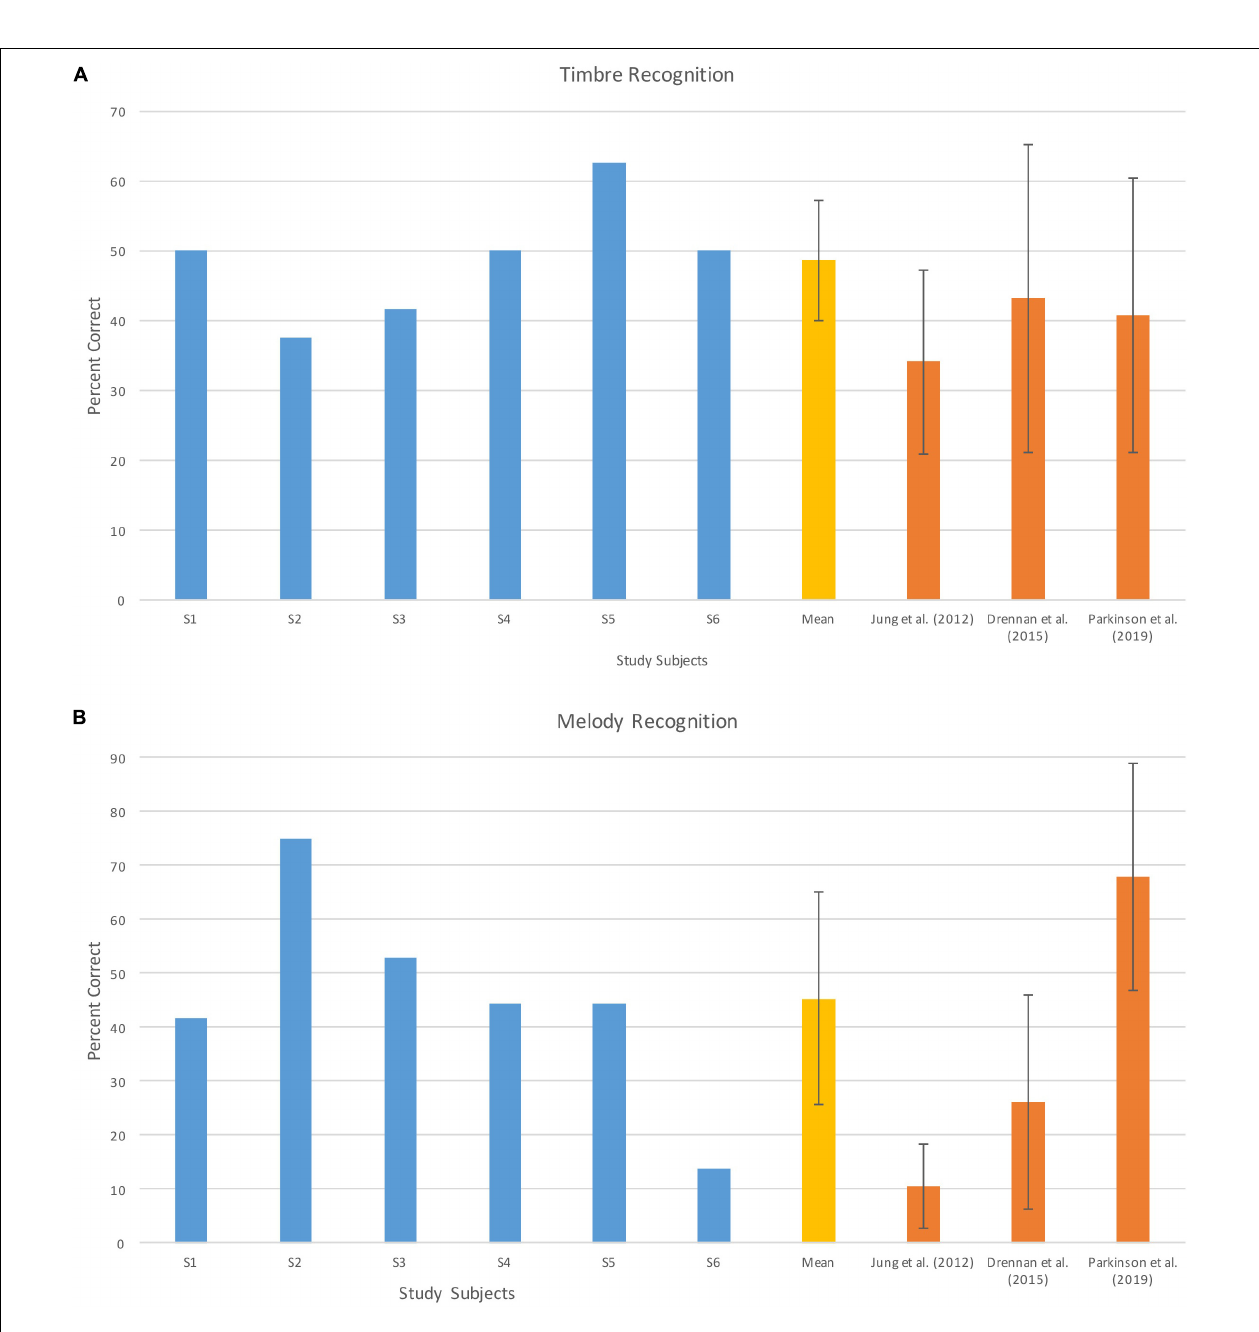
FIGURE 3 | Individual and mean timbre (A) and melody (B) recognition scores for study subjects and mean scores from previous studies. Error bars indicate ± 1 standard deviation. Data adopted from Jung et al. (2012), Drennan et al. (2015), and Parkinson et al.